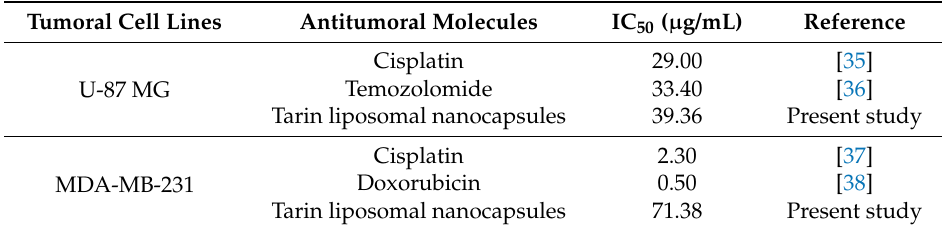
Table 2. Single-dose cytotoxicity of conventional drugs and encapsulated tarin to human tumoral cells after 24 h